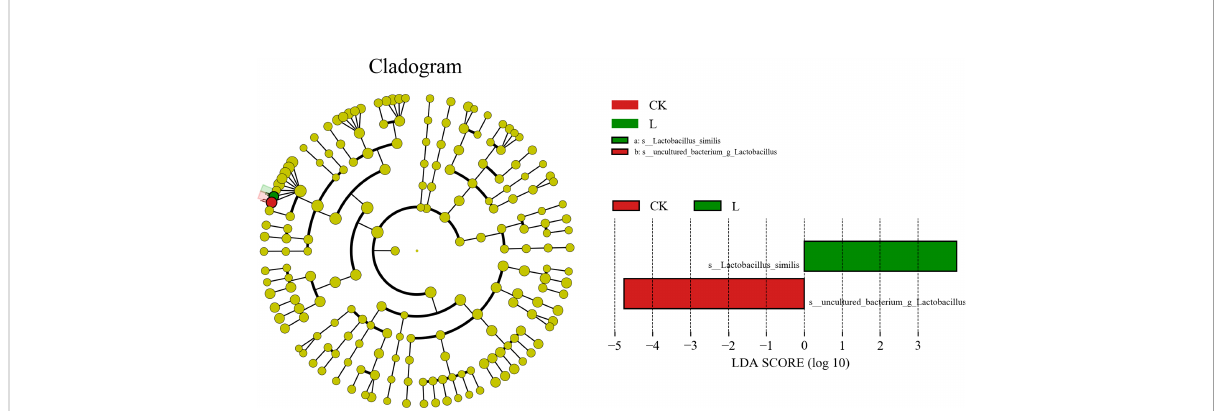
FIGURE 5 Comparison of microbial variations using the LEfSe online tool for mixed silage of KG and CF supplemented with L and M (CK, control; L, lactic acid bacteria; M, molasses; ML, lactic acid bacteria +